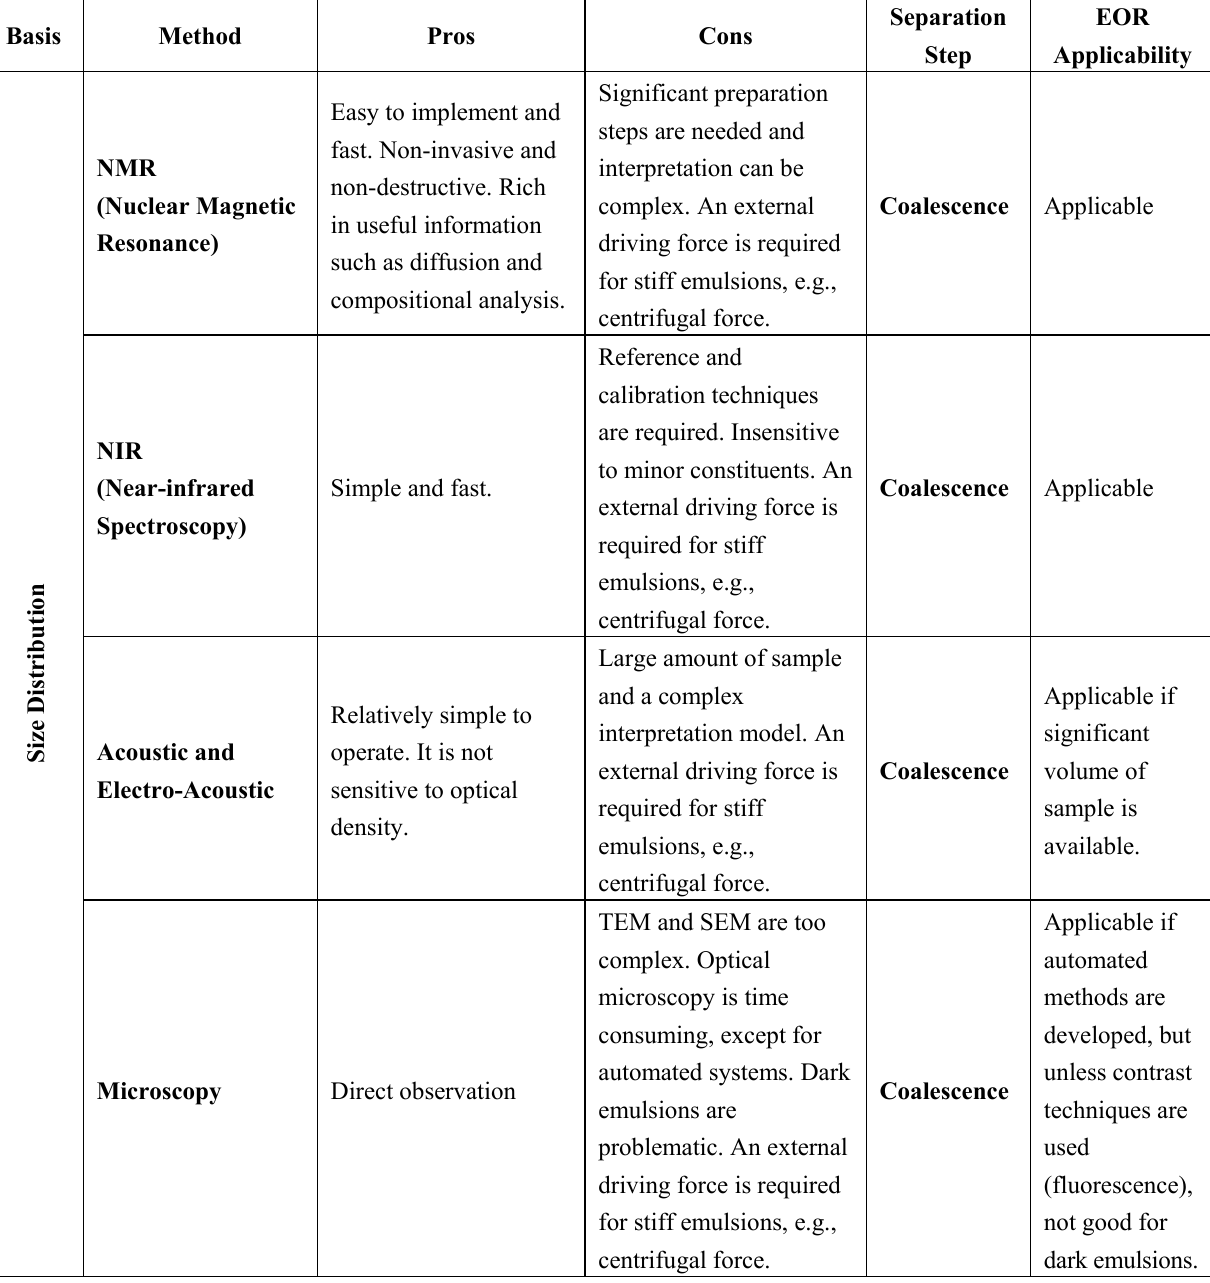
Table 1. Comparison of emulsion stability proxies described in this